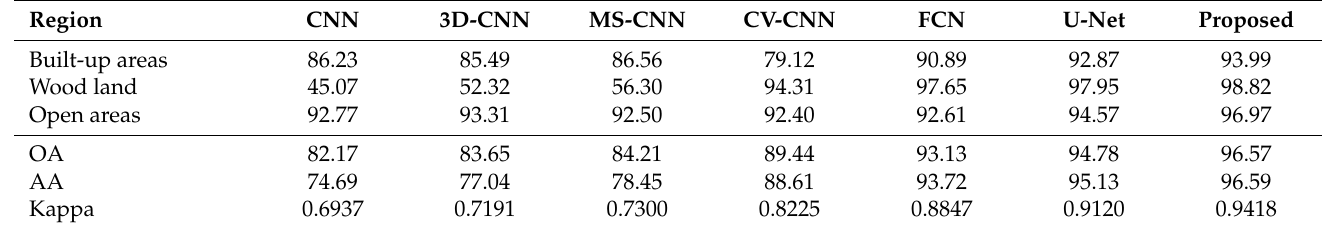
Table 8. Classification results of different methods in the Oberpfaffenhofen